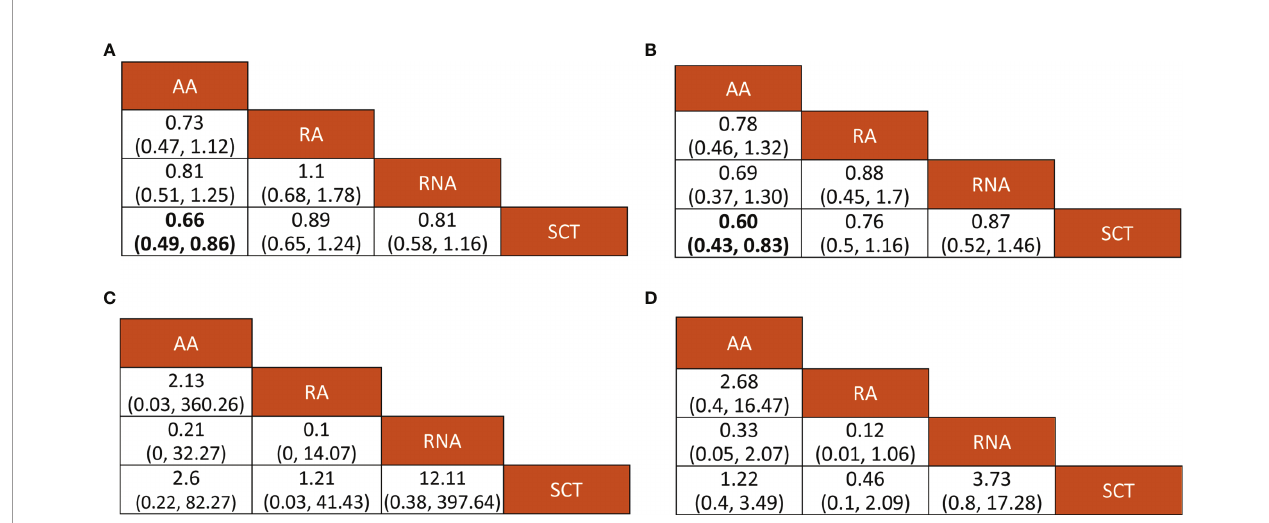
FIGURE 3 | Relative effects of various outcomes. Bold numerical values indicate signi fi cant pairwise comparison. (A) Disease-free survival, (B) overall survival; (C) any adverse events, and (D) grade 3 – 4 adverse events. AA, addition of capecitabine to adjuvant chemotherapy; RA, replacement of capecitabine to adjuvant chemotherapy; RNA, replacement of capecitabine to neoadjuvant chemotherapy; SCT, standard